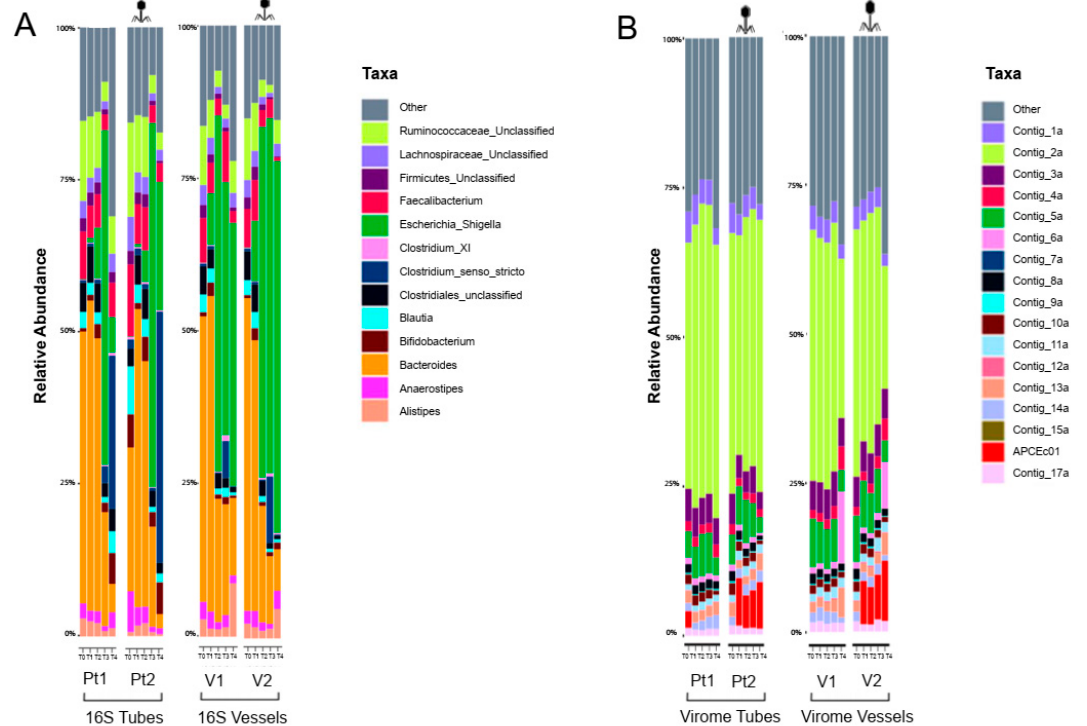
Figure 1. Sequencing results of faecal fermenter tubes and vessels during treatment 1 (no addition vs. Φ APCEc01 addition, FSI batch1) ( A ) stacked bar plots showing different bacterial abundances on genus level ( B ) stacked bar plots showing different viral abundances.